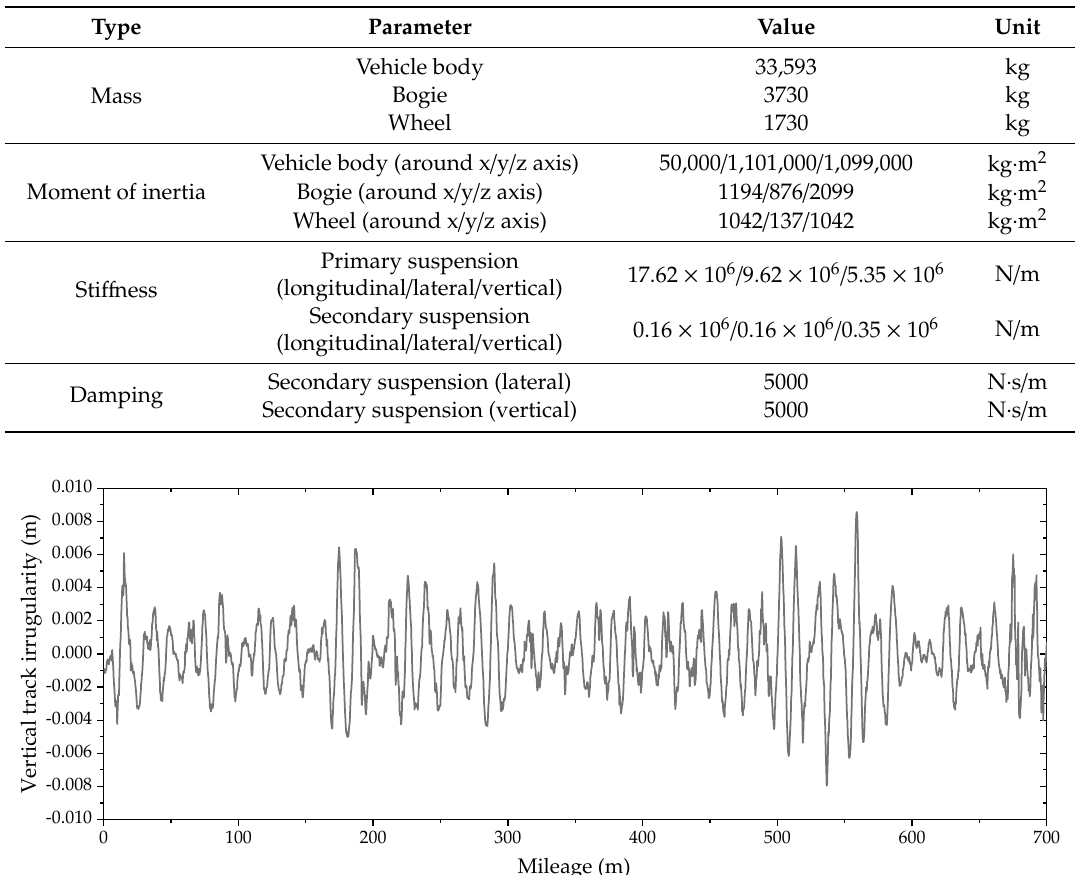
Figure 1. Vehicle-track system dynamic model. Table 1. Parameters of the vehicle model.